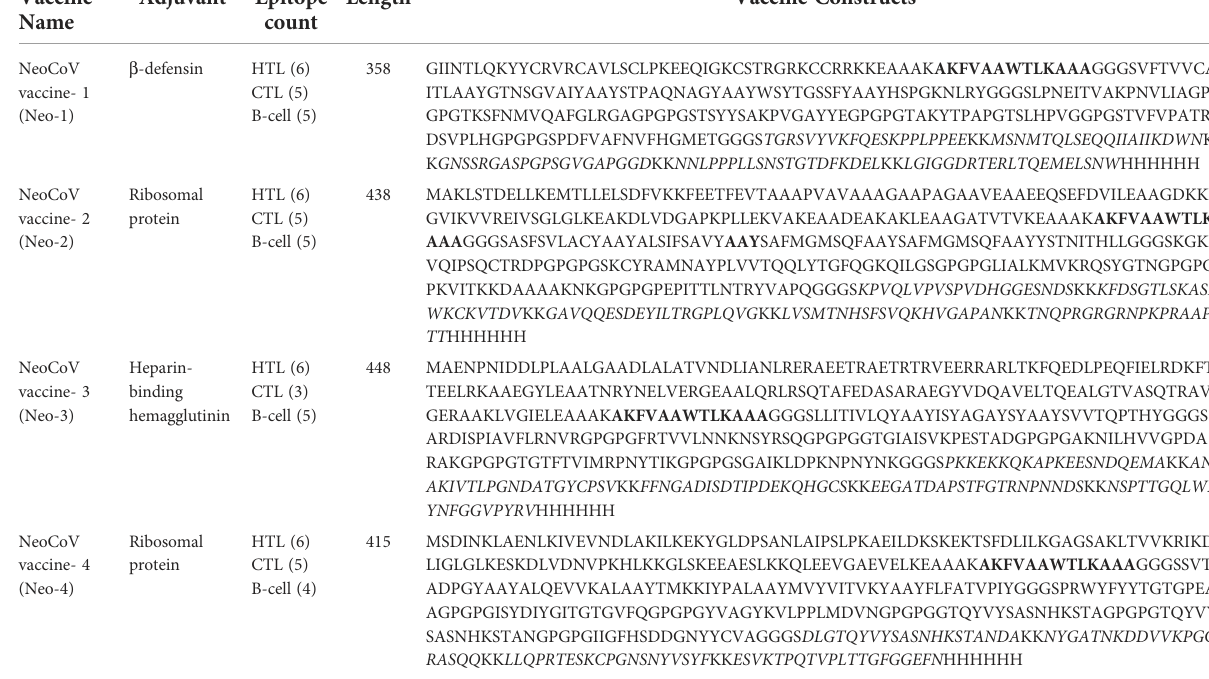
TABLE 5 The predicted vaccine constructs for NeoCoV. Vaccine